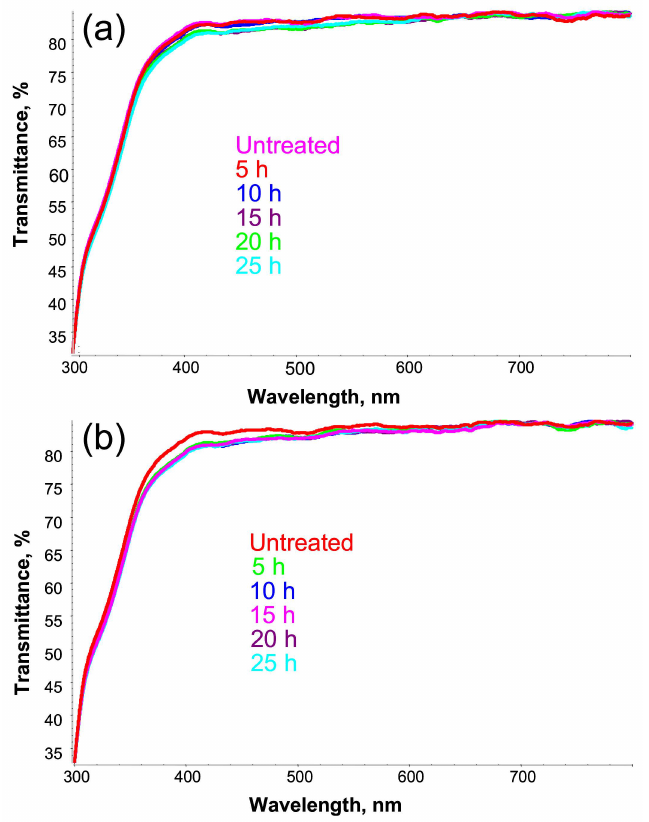
Figure 3. UV-visible transmittance of the trilayer composite after ( a ) thermal (120 ◦ C) and ( b ) solar irradiance treatment for different time